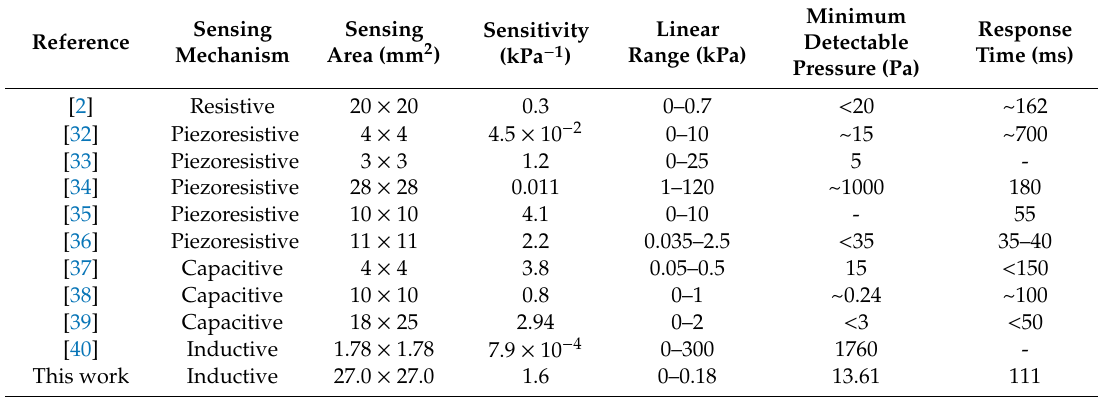
Table 1. The comparisons of the device performances on the current state-of-art flexible pressure sensing